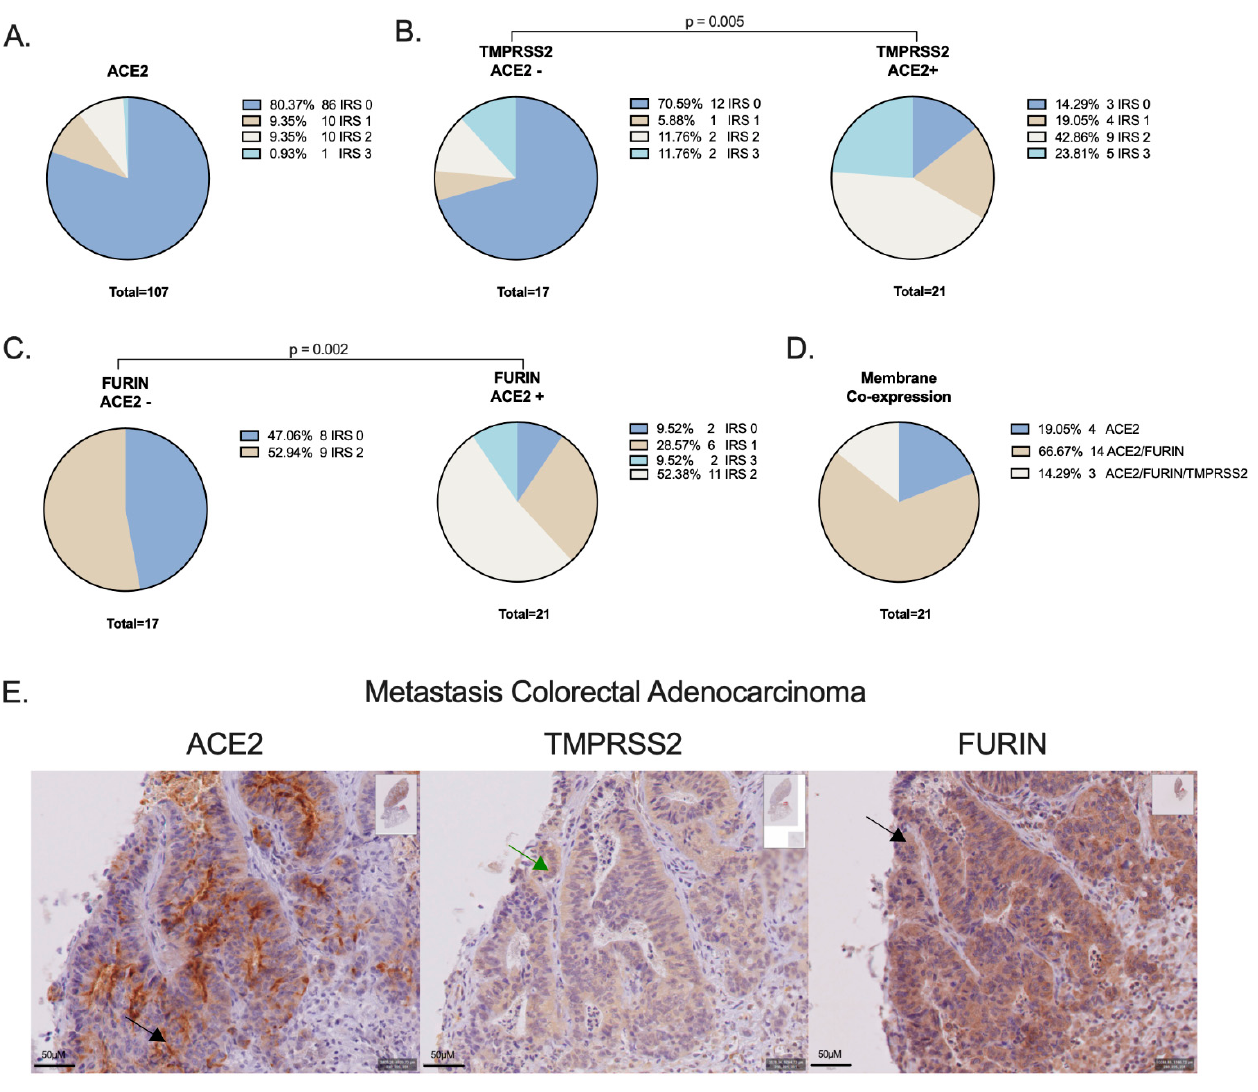
Figure 2. ( A ) Frequencies of ACE2 expression. ( B ) Frequencies of TMPRSS2 and ( C ) FURIN protein expression in ACE2 − and ACE2+ patient samples. ( D ) Frequencies of the membranous co-expression of ACE2, TMPRSS2, and/or FURIN in the same tissue sample. ( E ) ACE2, TMPRSS2, and FURIN expression in a colorectal adenocarcinoma metastasis in the lung.